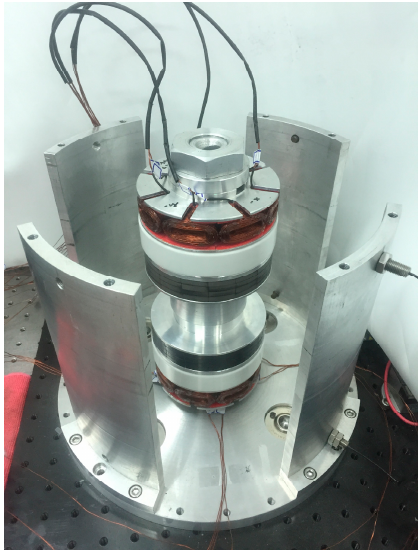
Figure 13. The stator of HMB and PMB.